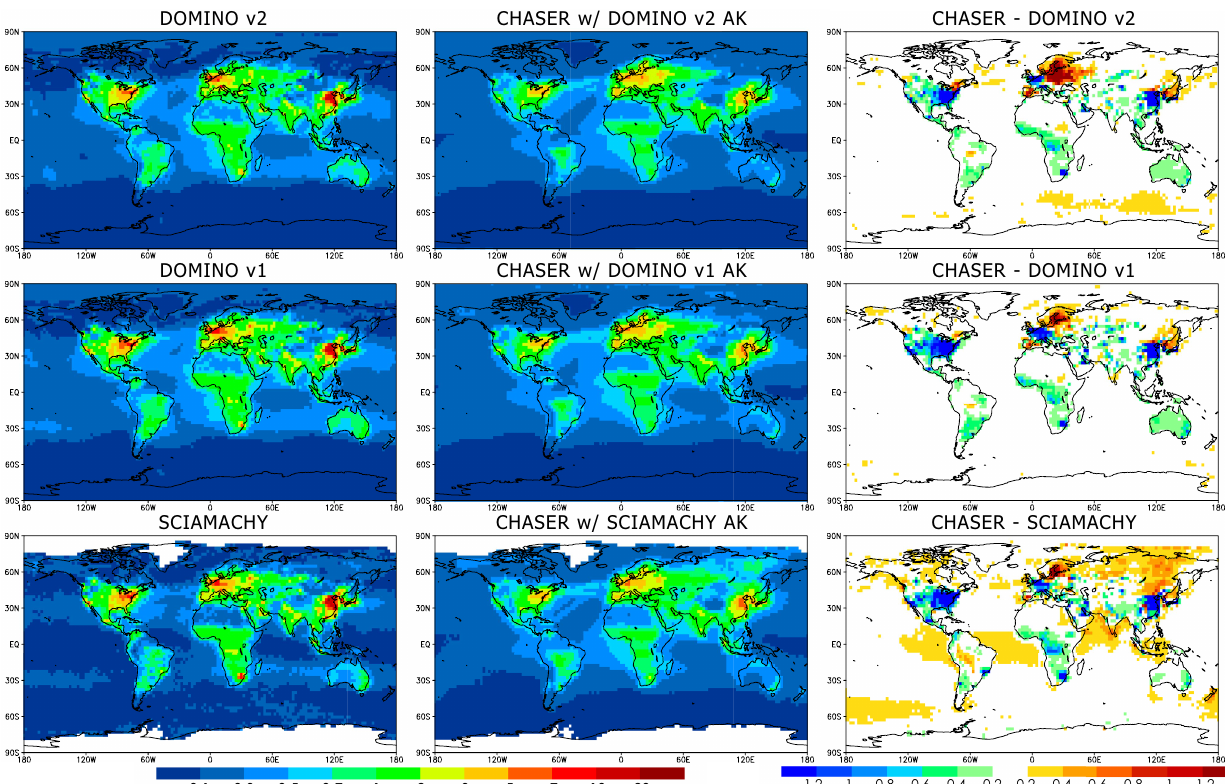
Fig. 2. Global distributions of annual mean tropospheric NO 2 columns (in 10 15 molec . cm − 2 ) obtained from the satellite retrievals (left columns): DOMINO v2 (upper rows), DOMINO v1 (middle rows), and SCIAMACHY (lower rows), and from the CHASER simulation estimated using the AK of each retrieval to be compared with the simulation (middle columns) for 2005. The red (blue) colour indicates relatively high (low) values. The differences between the retrievals and the CHASER simulation (the simulation minus the retrievals) are shown in the right columns; the red (blue) colour indicates that the CHASER is larger (smaller) than the satellite retrievals.